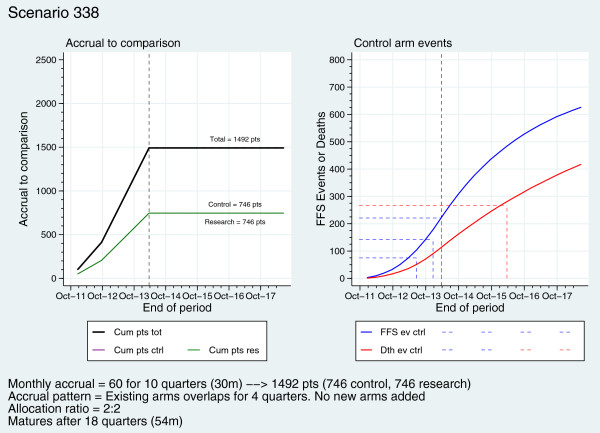
An example of accrual scenarios for the new comparison and project of cont rol arm events.